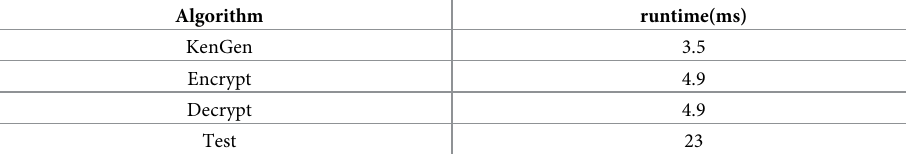
Table 9. Computational efficiency of